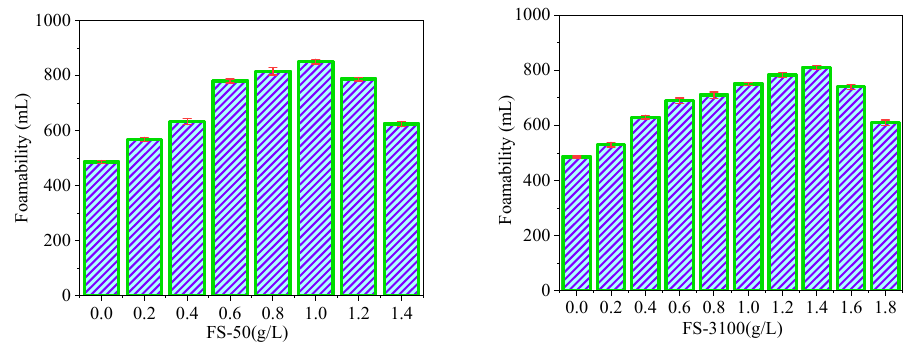
Figure 5. Effects of FS-50 and FS-3100 on foaming ability.